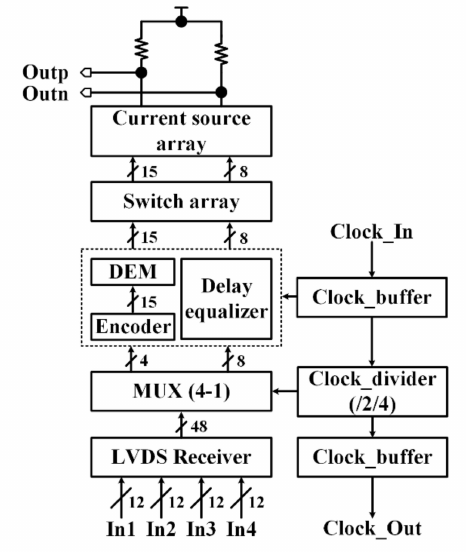
Figure 1. Digital-to-analog converter (DAC)